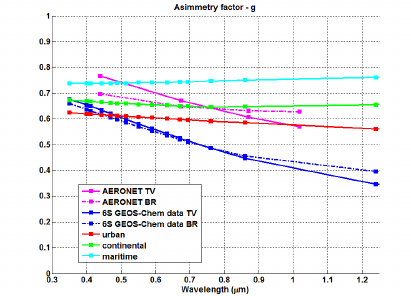
Figure 4. Asymmetry factor (g) retrieved from AERONET and simulated with 6SV using microphysical properties from the five